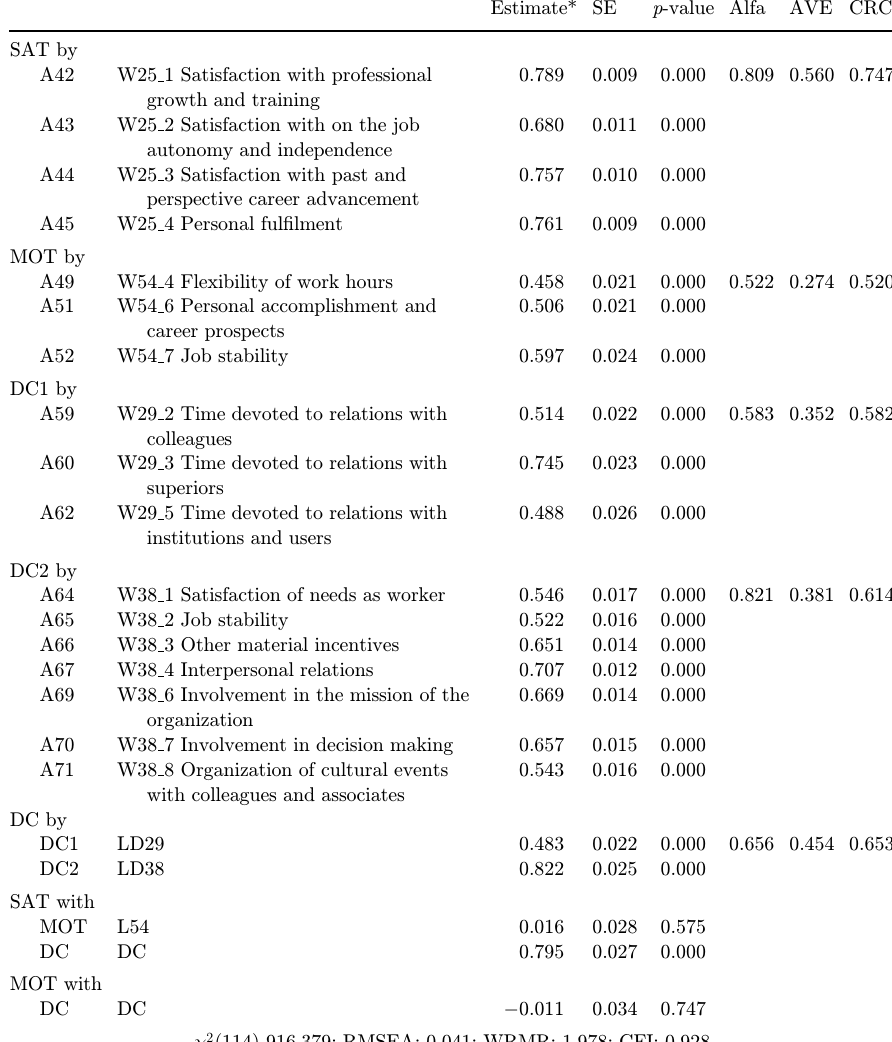
Table A.3. Results of the measurement equations models.